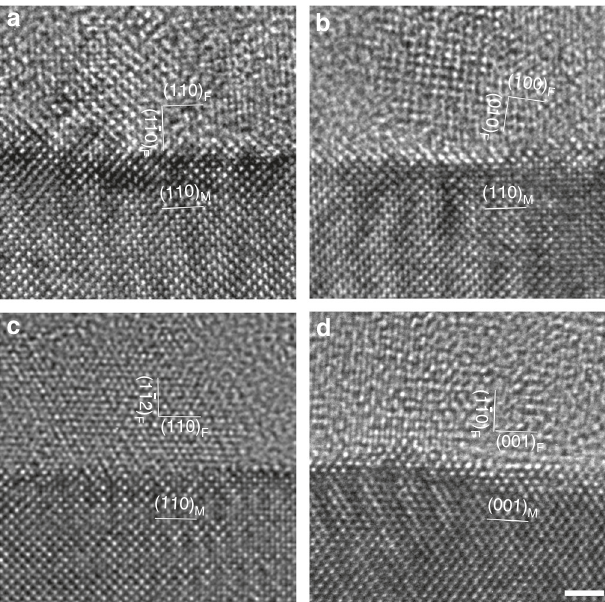
Fig. 4 Cross-sectional HRTEM images along the [001] and [110] axes of the austenitic matrix showing the interface between the passive fi lm and steel matrix. It is seen that the passive fi lm is mainly amorphous, with some nanocrystals. A series of HRTEM images obtained from variant orientations and locations indicate that the nanocrystals feature face-centered cubic structure. In most cases, the nanocrystals have crystallographic orientations with austenitic matrix but occasionally not. This fi gure displays typical con fi gurations where the orientation relationships between the nanocrystals in the passive fi lm and the single-crystalline substrate are labeled. a Film (110) || FeCr 15 Ni 15 (110) and fi lm (1 – 10) || FeCr 15 Ni 15 (1 – 10). b The crystal is randomly oriented with no orientation relationship with the austenitic matrix. c Film (110) || FeCr 15 Ni 15 (110) and fi lm (1 – 10) || FeCr 15 Ni 15 (1 – 12). d Film (001) || FeCr 15 Ni 15 (001) and fi lm (1 – 10) || FeCr 15 Ni 15 (1 –